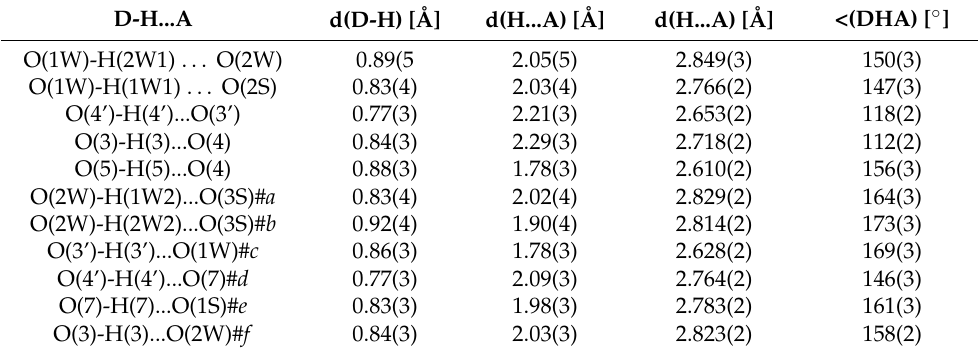
Table 3. Geometry of O-H . . . O hydrogen bonds for crystal 1